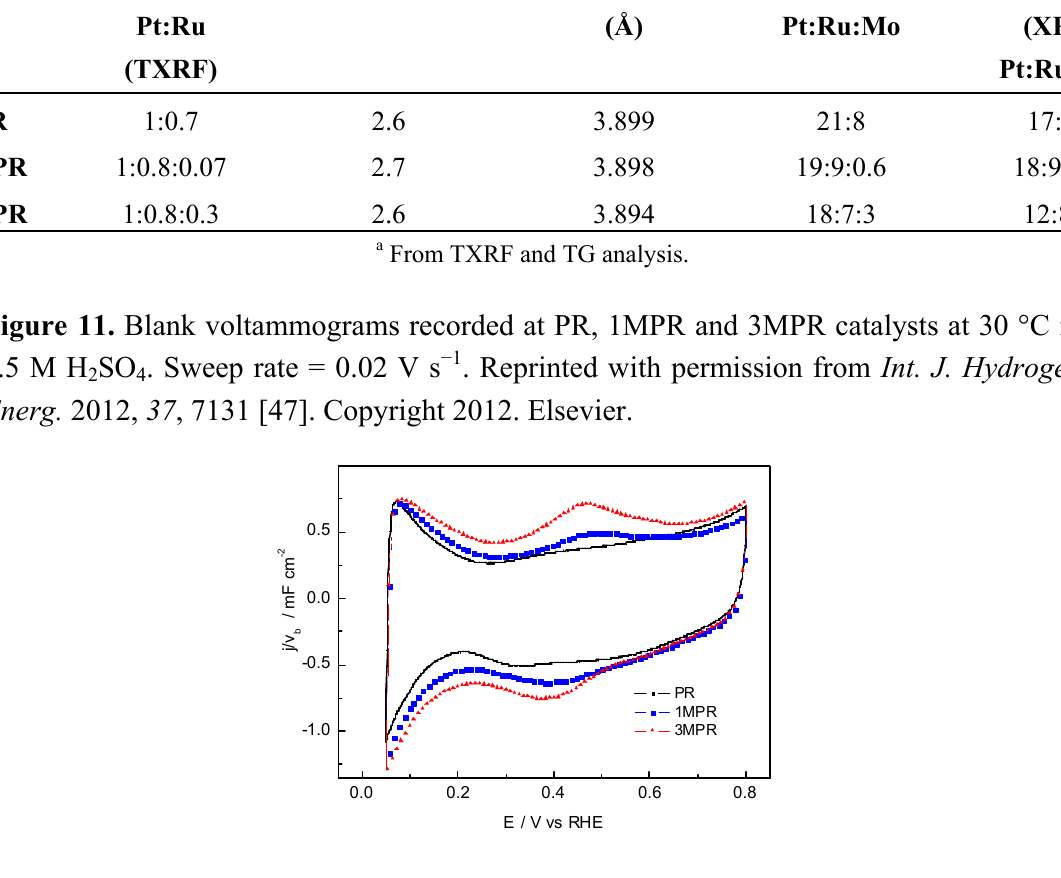
Figure 12. CO stripping record of PR, 1MPR and 3MPR catalysts at 20 °C (above) and 70 °C (below) in 0.5 M H